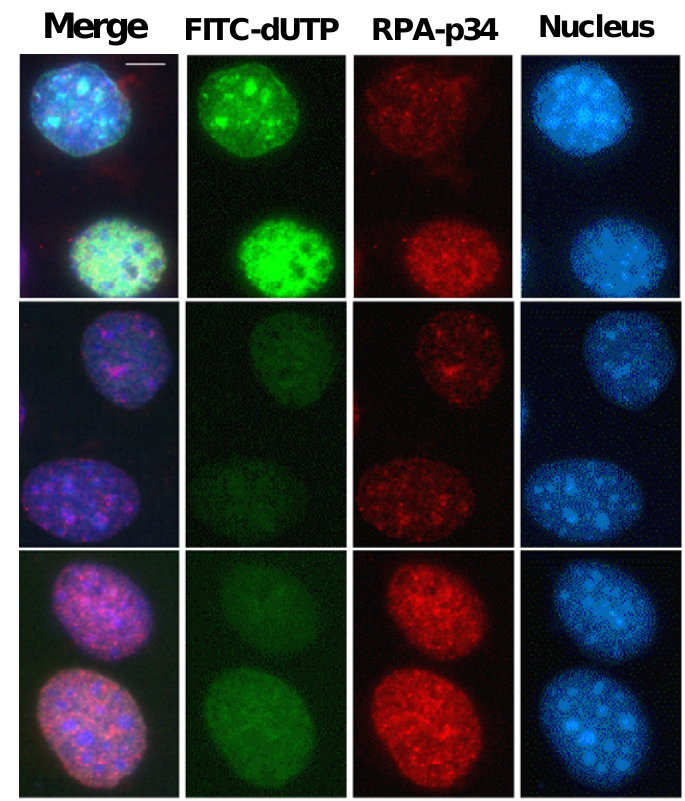
Figure 5. Effect of inhibitors on replication in the nucleus. (A) Immunofluorescent localization of chromatin-bound RPA. NIH3T3 cells was treated by hypotonic shift with FITC-dUTP and C12 or aphidicolin. After 90 min, cells were extracted with cytoskelton buffer containing 0.5% Triton X-100 for 5 min and fixed with 3.7% formaldehyde. RPA- p34 subunit was detected by indirect immunofluorescence with anti-RPA monoclonal antibody and Alexa 594-conjugated anti-mouse antibody. Bar indicates 20 μ m. (B) Quantification of the percentage of FITC-dUTP incorporated nuclei showing RPA foci pattern. At least 100 cells were counted. RPA foci were classified into large discrete foci (red), co-localized with FITC (green), and faint (blue). (C) Localization of replication foci. Hypotonic shift treated cells were incubated for 2 h, and then chromatin-bound PCNA and pol α p180 were detected. Bar indicates 40 μ m. (D) In three independent experiments, 200 cells were counted and the localization of PCNA protein foci in nucleus was classified as very fine granules in the nucleus (very early S), bright foci throughout the nucleus (early S), bright large foci near heterochromatin (mid S) and a few large foci (late